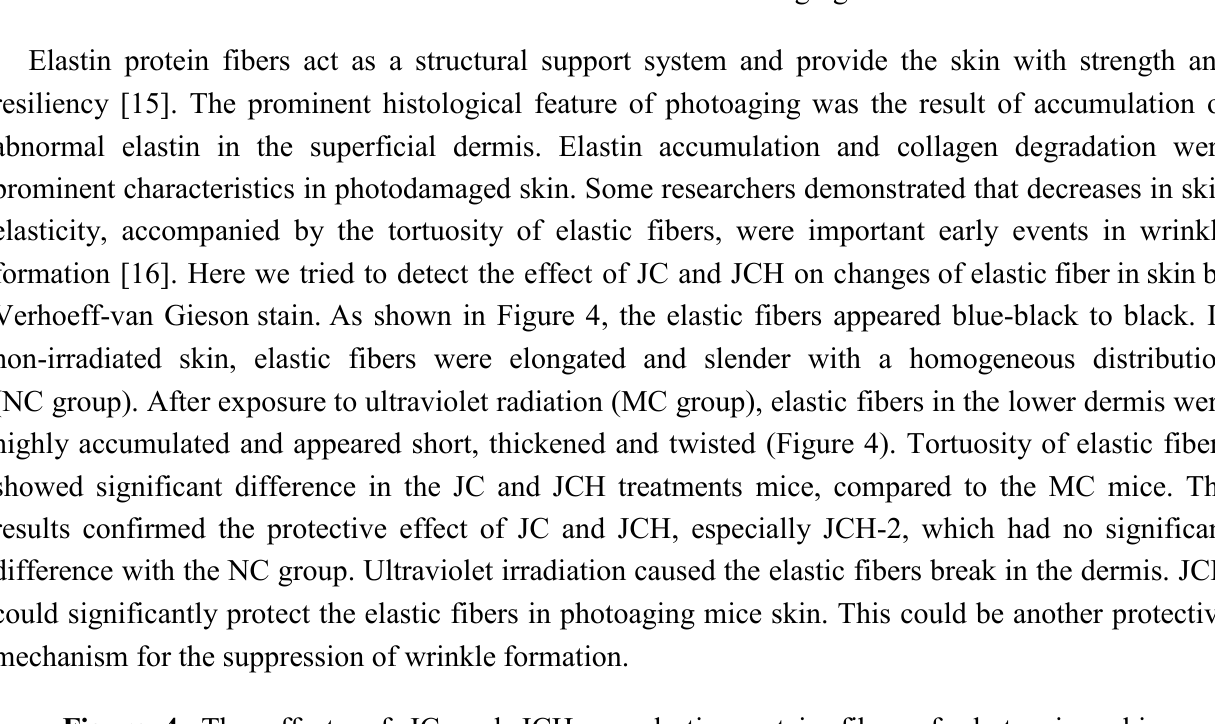
Figure 4. The effects of JC and JCH on elastin protein fiber of photoaging skin (magnification 200×); Blue-black to black: elastic fibres (